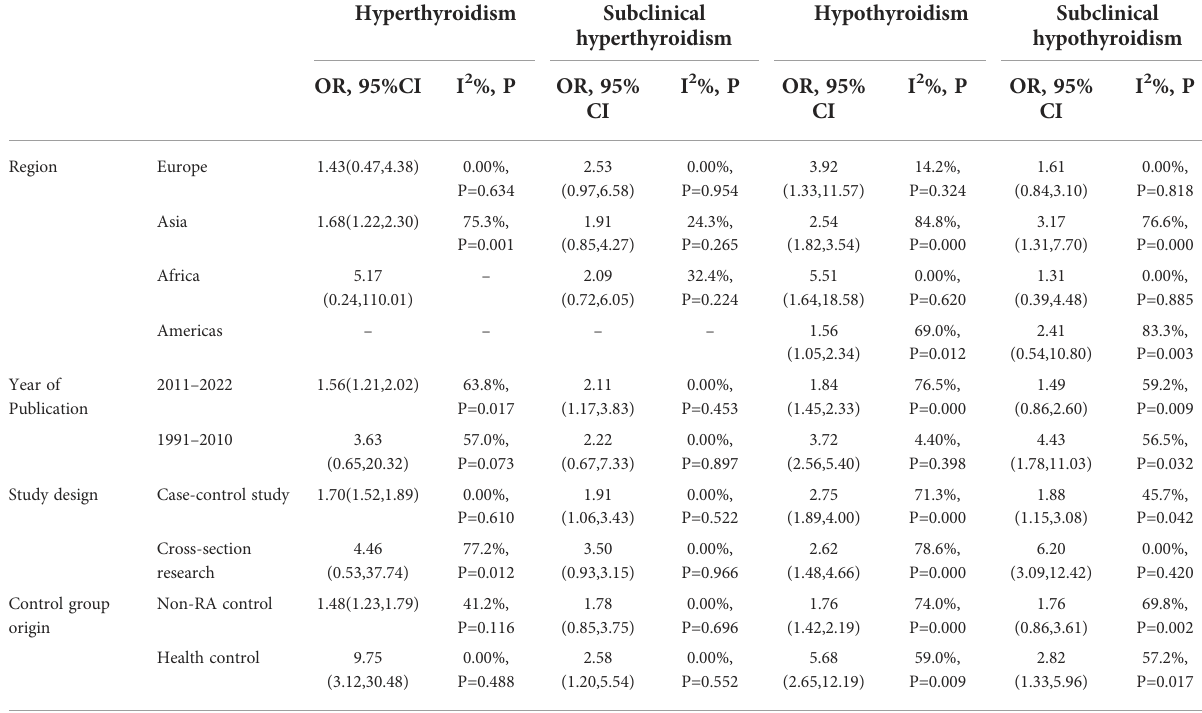
TABLE 2 Subgroup analysis of region, year of Publication, study design, and control group